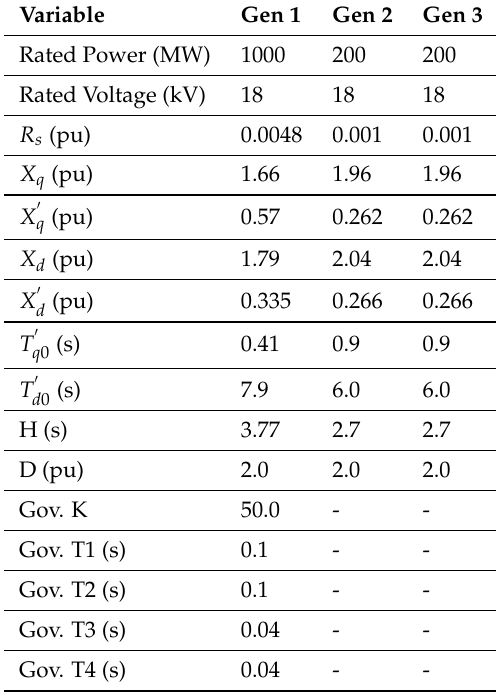
Table A1. Synchronous Machine Model